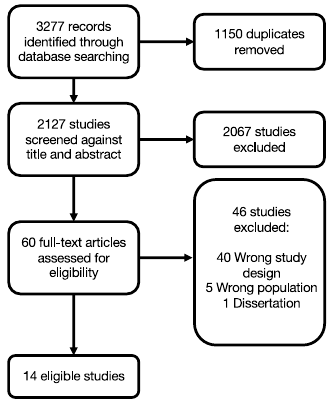
Figure 1. PRISMA flow diagram.